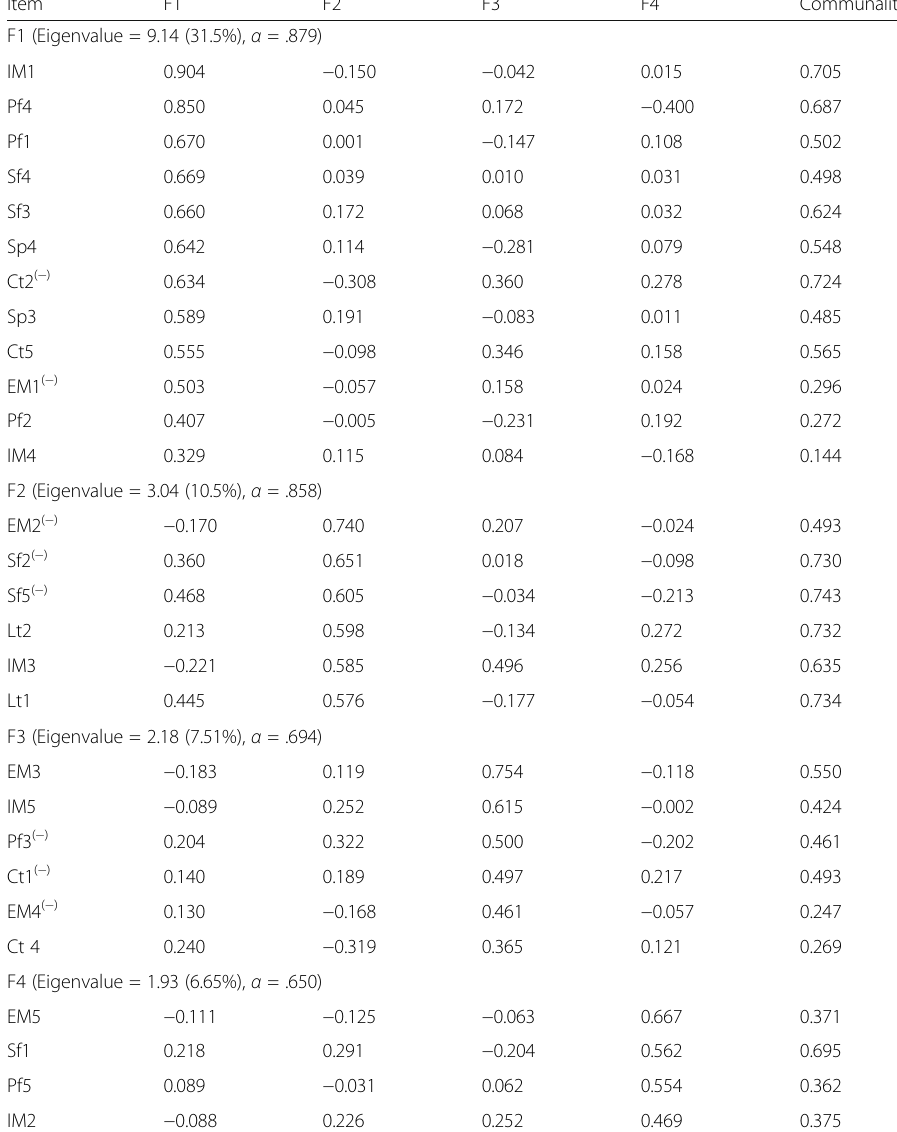
Table 2 Results of factor analysis with promax rotation Item F1 F2 F3 F4 Communality